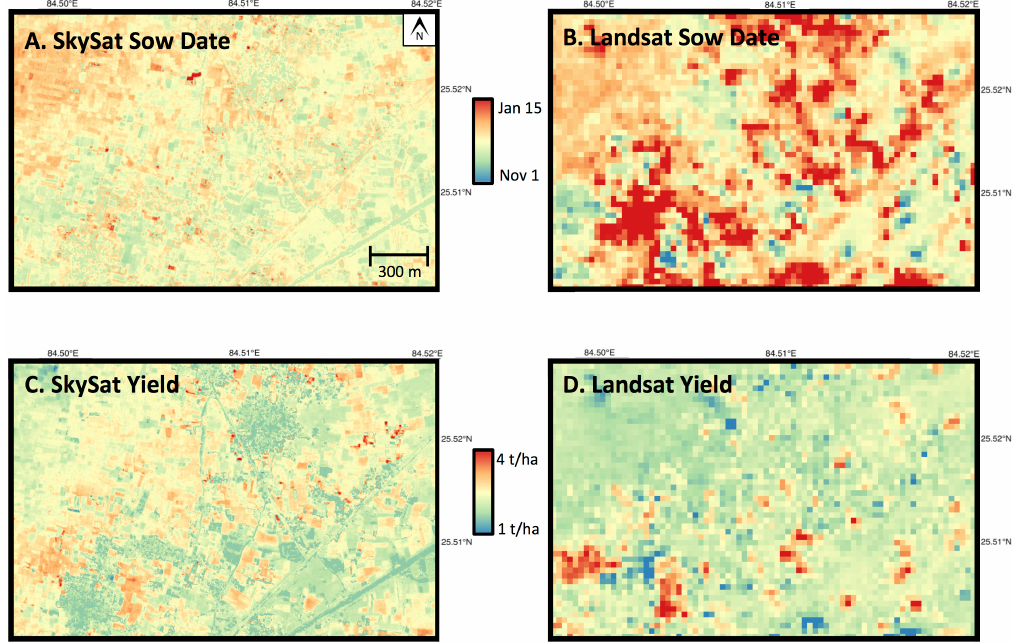
Figure 9. Predicted sow date using SkySat ( A ) and Landsat ( B ) as well as predicted yields using SkySat ( C ) and Landsat ( D ). All predictions were done using crop cut data for calibration. SkySat predictions allow one to examine across and within field variability, which cannot be observed using Landsat predictions.